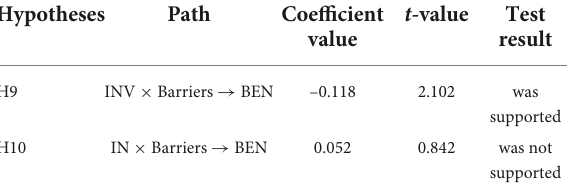
TABLE 8 Test of interference effect.